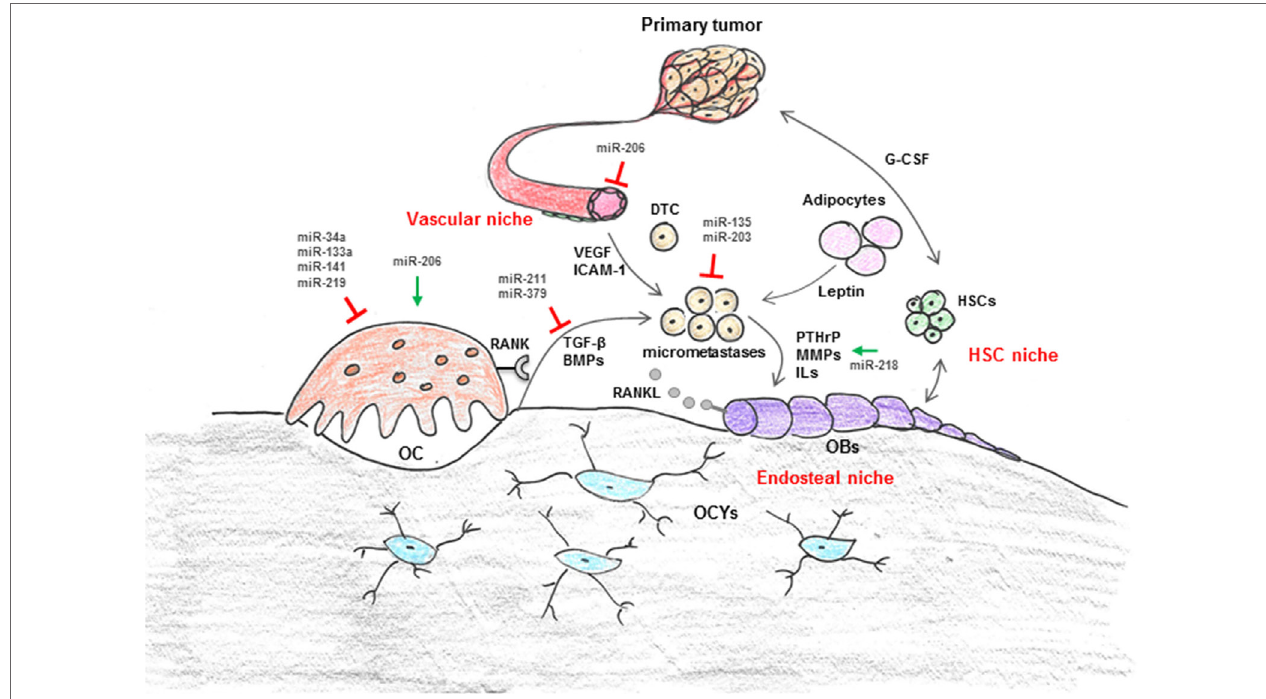
FigURe 1 | Regulation of cellular interaction in breast cancer bone metastasis by microRNA (miRNAs). The bone microenvironment (BME) is composed of cellular entities, including hematopoietic stem cells (HSC niche), osteoblasts (OBs), osteoclasts (OCs), and adipocytes (endosteal niche) as well as vascular endothelial cells and pericytes (vascular niche). These niches are suggested to control survival, dormancy, and growth of disseminated tumor cells (DTCs) through production of cytokines (i.e., leptin, G-CSF, VEGF, etc.) and intracellular signals in addition to cell-to-cell contact. In a physiological context, the highly coordinated cross talk between bone-forming OBs and bone-resorbing OCs maintains bone mass. OC function is regulated via OB and osteocyte (OCYs) derived RANKL. In the context of metastatic breast cancer disease, breast cancer cells severely disturb the balance between bone formation and resorption through secretion of various growth factors and cytokines [i.e., interleukins (ILs), parathyroid hormone-related protein (PTHrP), matrix metalloproteinases (MMPs), RANKL]. Recently, it has also been suggested that cells from the primary tumor themselves modify the distant microenvironment, for example through systemic factors (i.e., VEGF, TGF- β , G-CSF, miRNAs), in order to make it more attractive for DTCs. Several components of the BME are negatively (red blocks) or positively (green arrows) regulated by